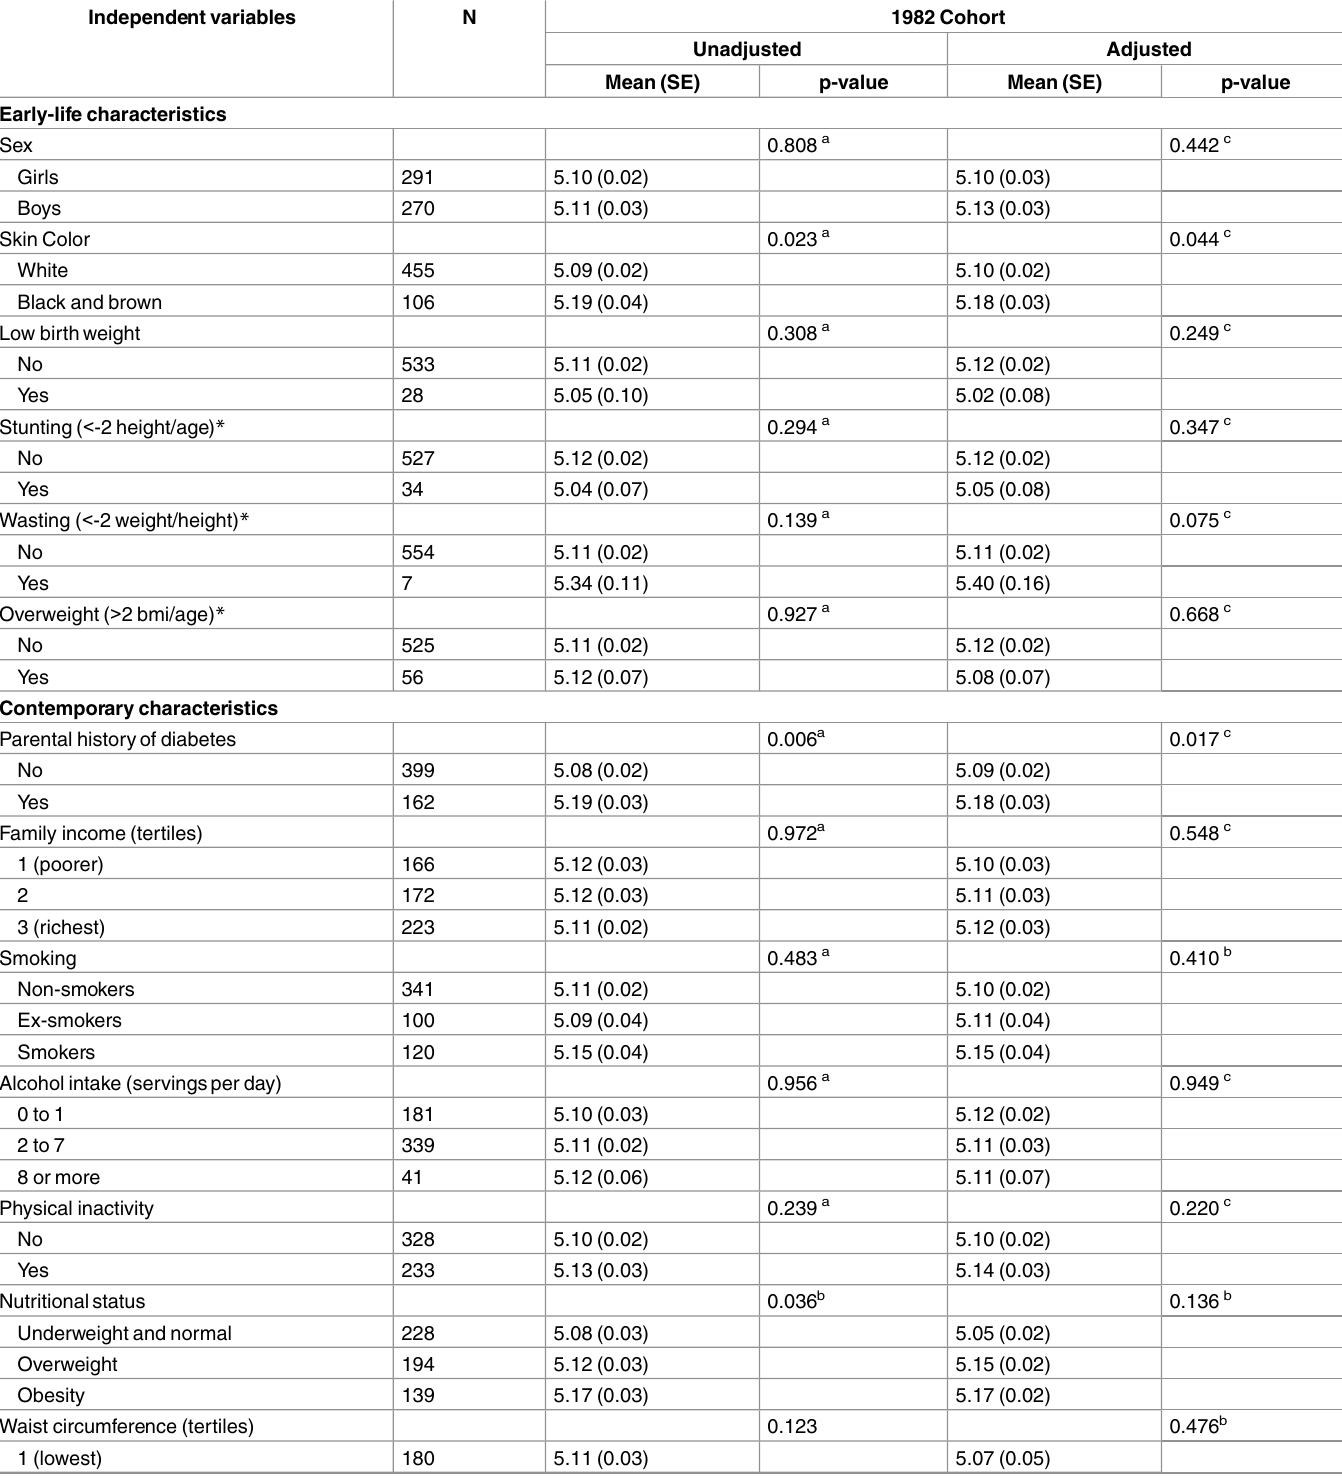
Table 2. Unadjustedand adjusted mean and SE for HbA 1c according to early-life, demographic, socioeconomicand behavioral factors,parenthis- toryof diabetes, nutritionalstatusand waistcircumferenceamongadultsin the 1982 Pelotas